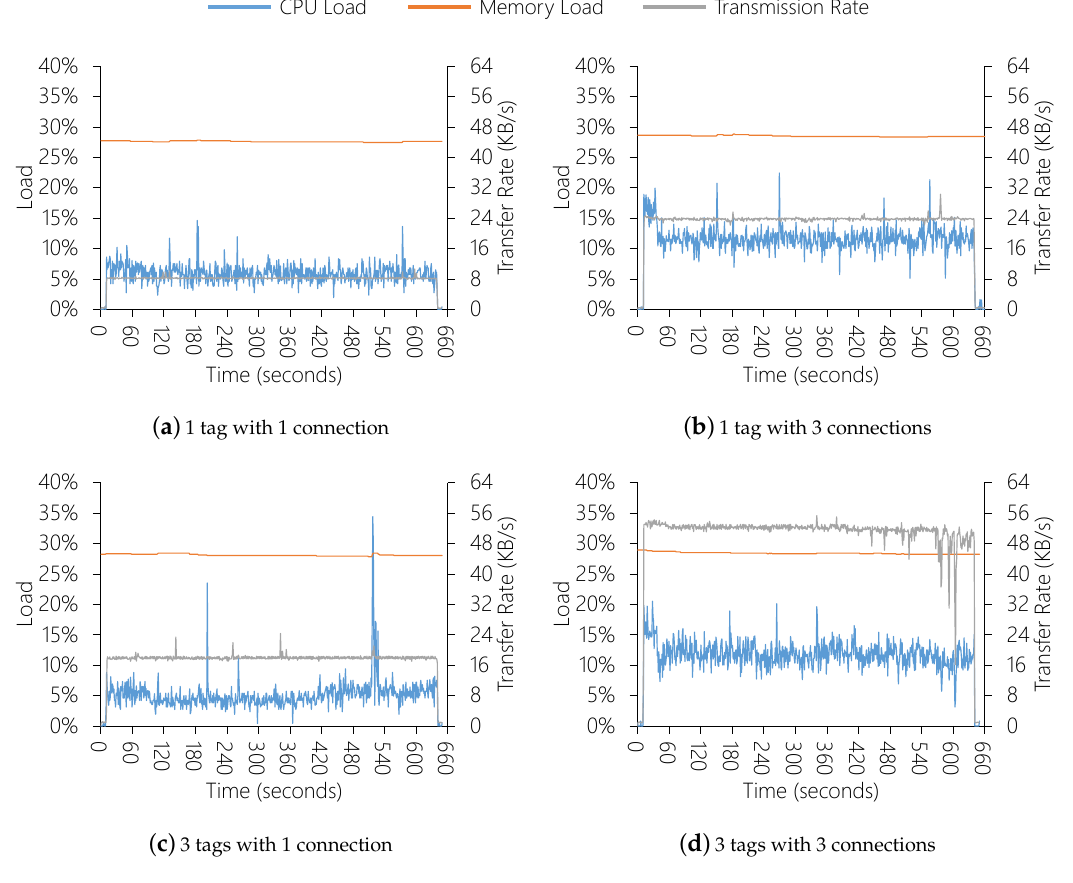
Figure 11. Results without parameters